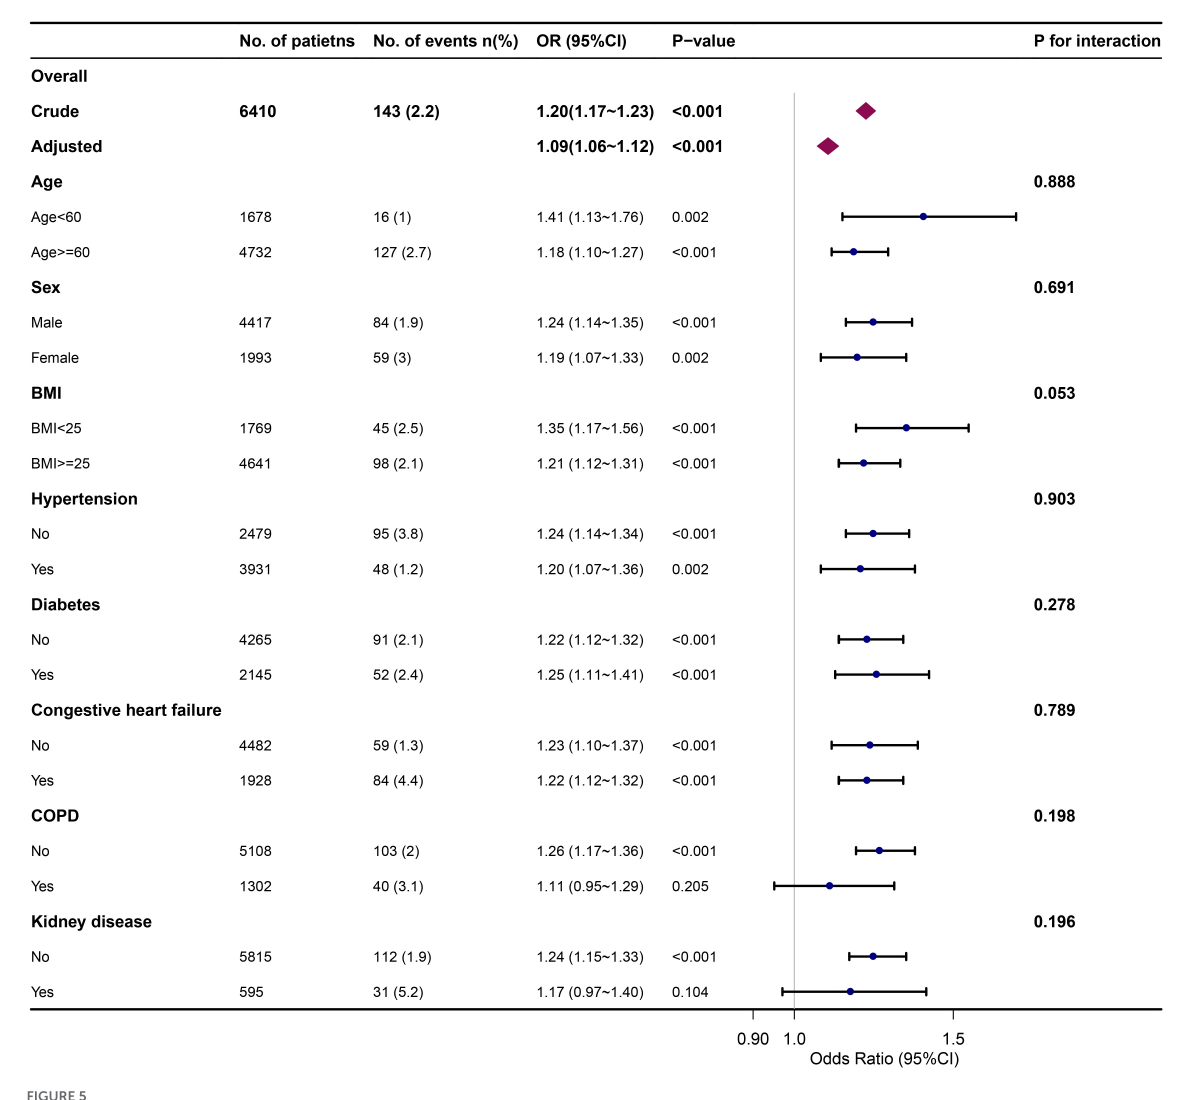
FIGURE5 Association between initial AG and in-hospital mortality in different subgroups. Each stratification analysis adjusted for all the confounding factors (age, sex, ethnicity, BMI, insurance, hypertension, diabetes, congestive heart failure, stroke, COPD, kidney disease, liver disease, malignancy, type of surgery, SOFA score, SAPS II score, leukocyte, platelet, hemoglobin, creatinine, urea, PH, base excess, PO 2 , PCO 2 , glucose, heart rate, respiratory rate, MBP, temperature, SPO 2 ) except the stratification factor